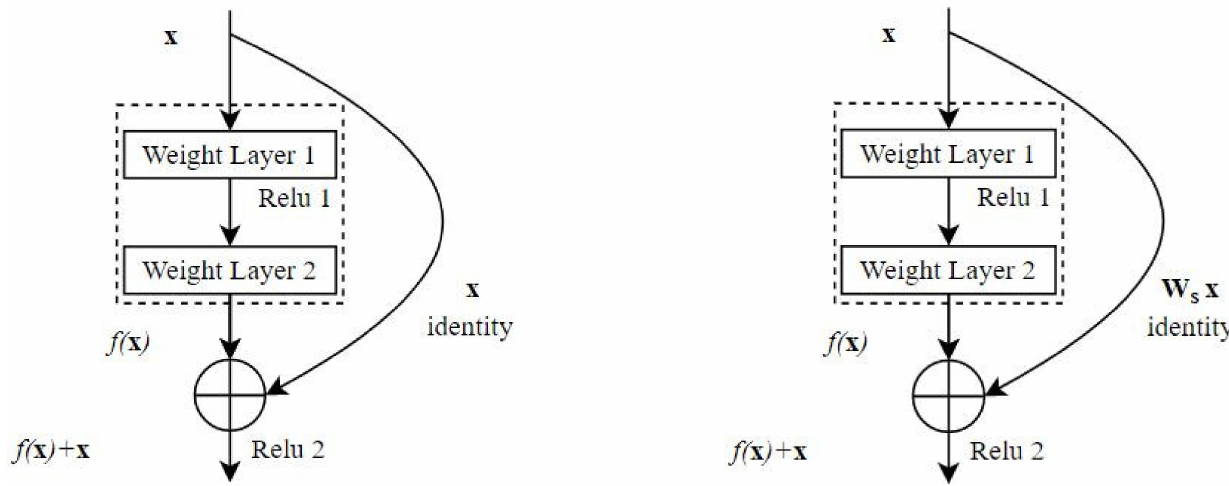
Figure 5. Skip Connection Building